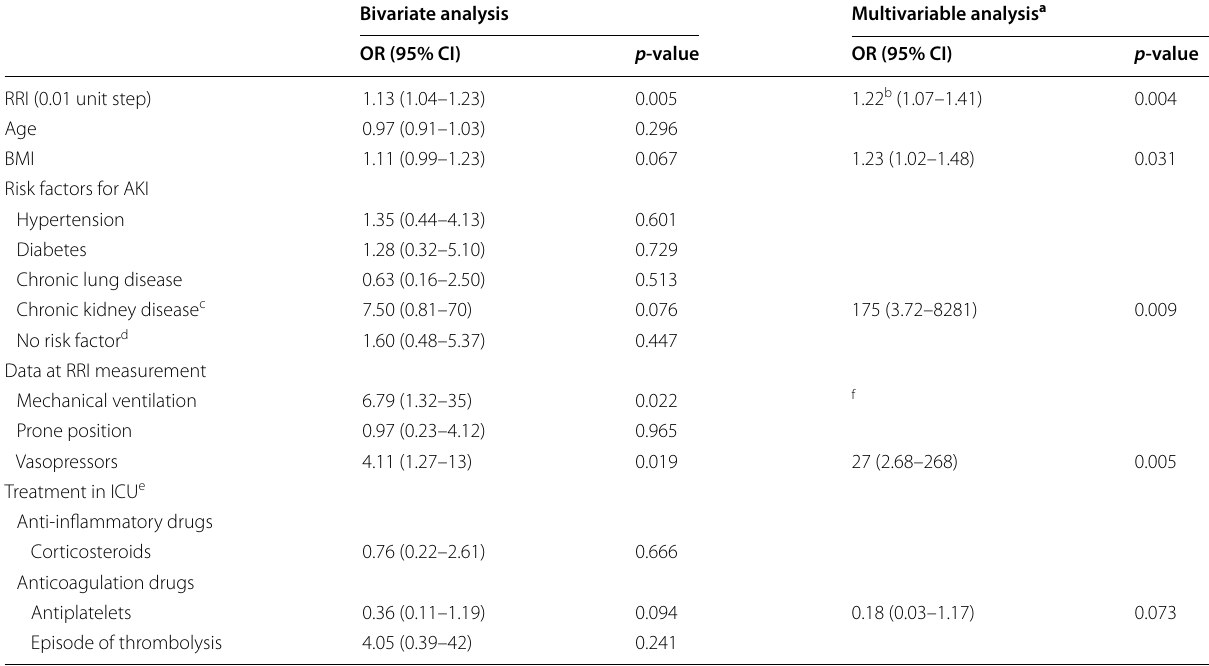
Table 2 Bivariate and multivariable analysis showing the association with